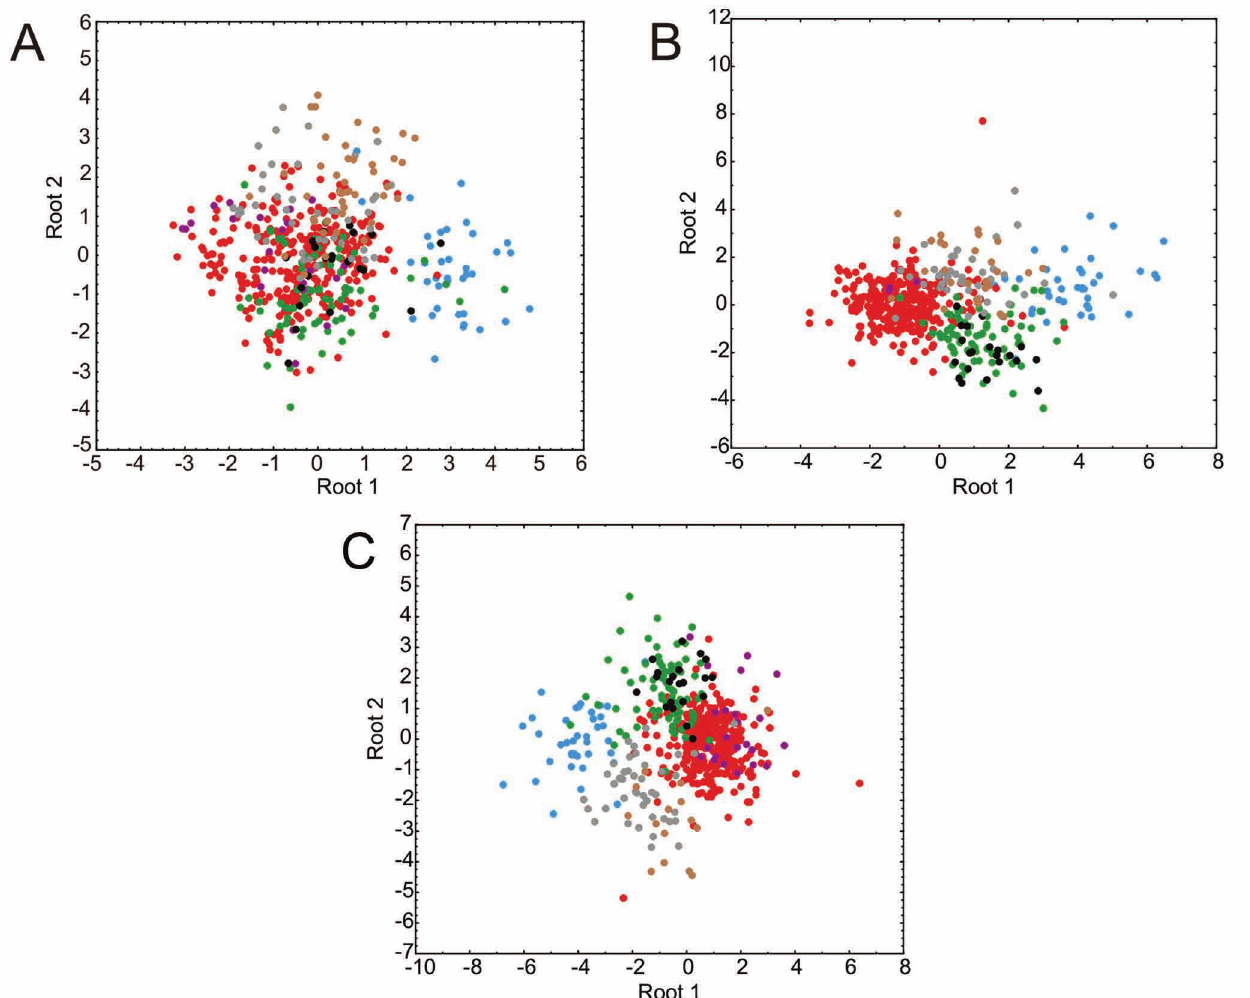
Fig. 4. Canonical variance analysis derived from the discriminant function analysis of the species included in the Herichthys bartoni species group. A) Meristic data B) Morphometric data adjusted by the method of Mossimann C) Morphometric data adjusted as proportions. Symbology: Blue: H. bartoni , Red: H. cf. labridens , Green: H. labridens , Violet: H. molango , Black: H. pame , Gray: H. pantostictus , Brown: H. steindachneri . Table 1. Matrix of classification for the seven species of the Herichthys bartoni species group derived from the Discriminant Function Analysis (DFA). The data are presented as percents of correct classification for each data